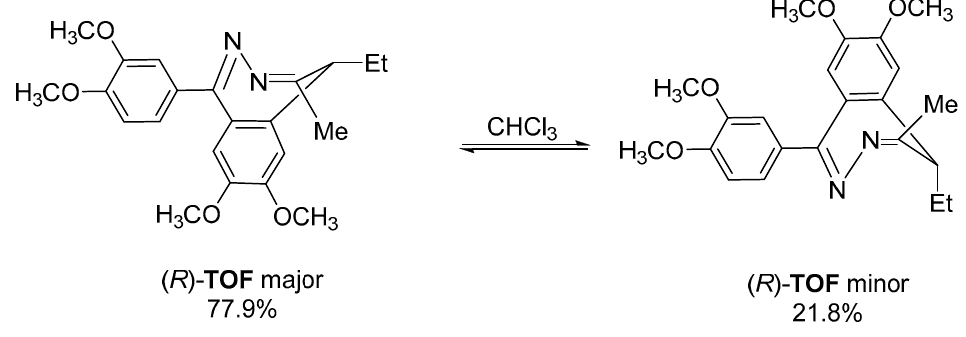
Figure 8. The conversion of the conformers of ( R )-TOF .